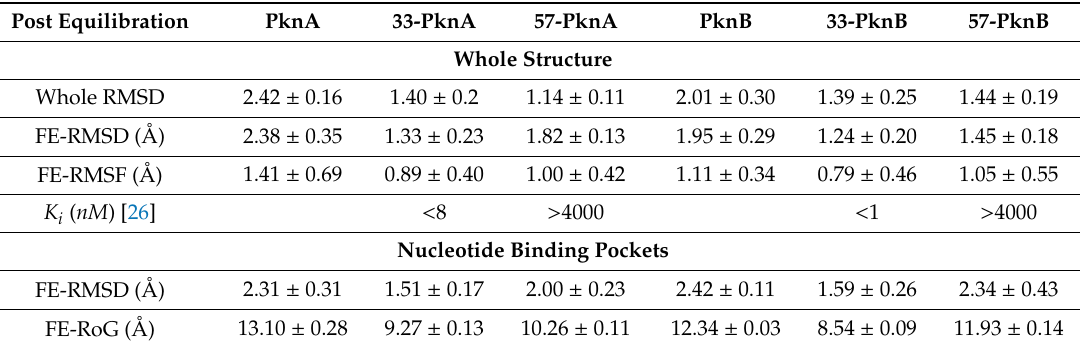
Table 1. Conformational analysis of protein kinases A and B complexed with compounds 33 and 57 . Estimated K i value is also